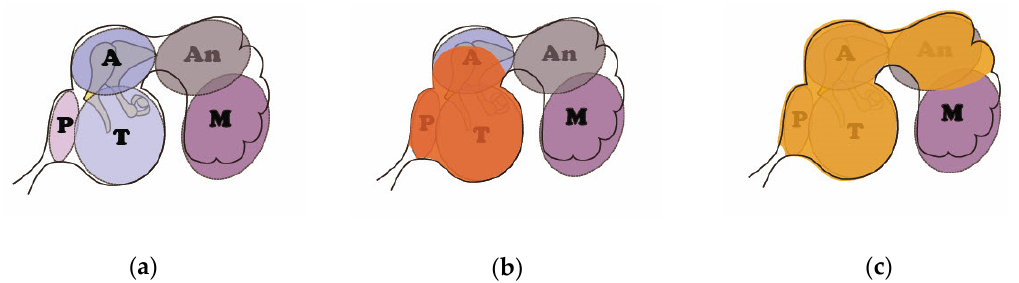
Figure 6. Revised system for staging and classifying of middle ear cholesteatomas to be treated by non-TEES based on the PTAM System for Staging and Classification of Middle Ear Cholesteatomas as proposed by the Japan Otological Society [37] ( a ) The middle ear (P: protympanum; T: tympanic cavity; A: attic; An: antrum; M: mastoid cells). ( b ) Non-powered TEES (orange overlay). ( c ) Powered TEES (yellow overlay).